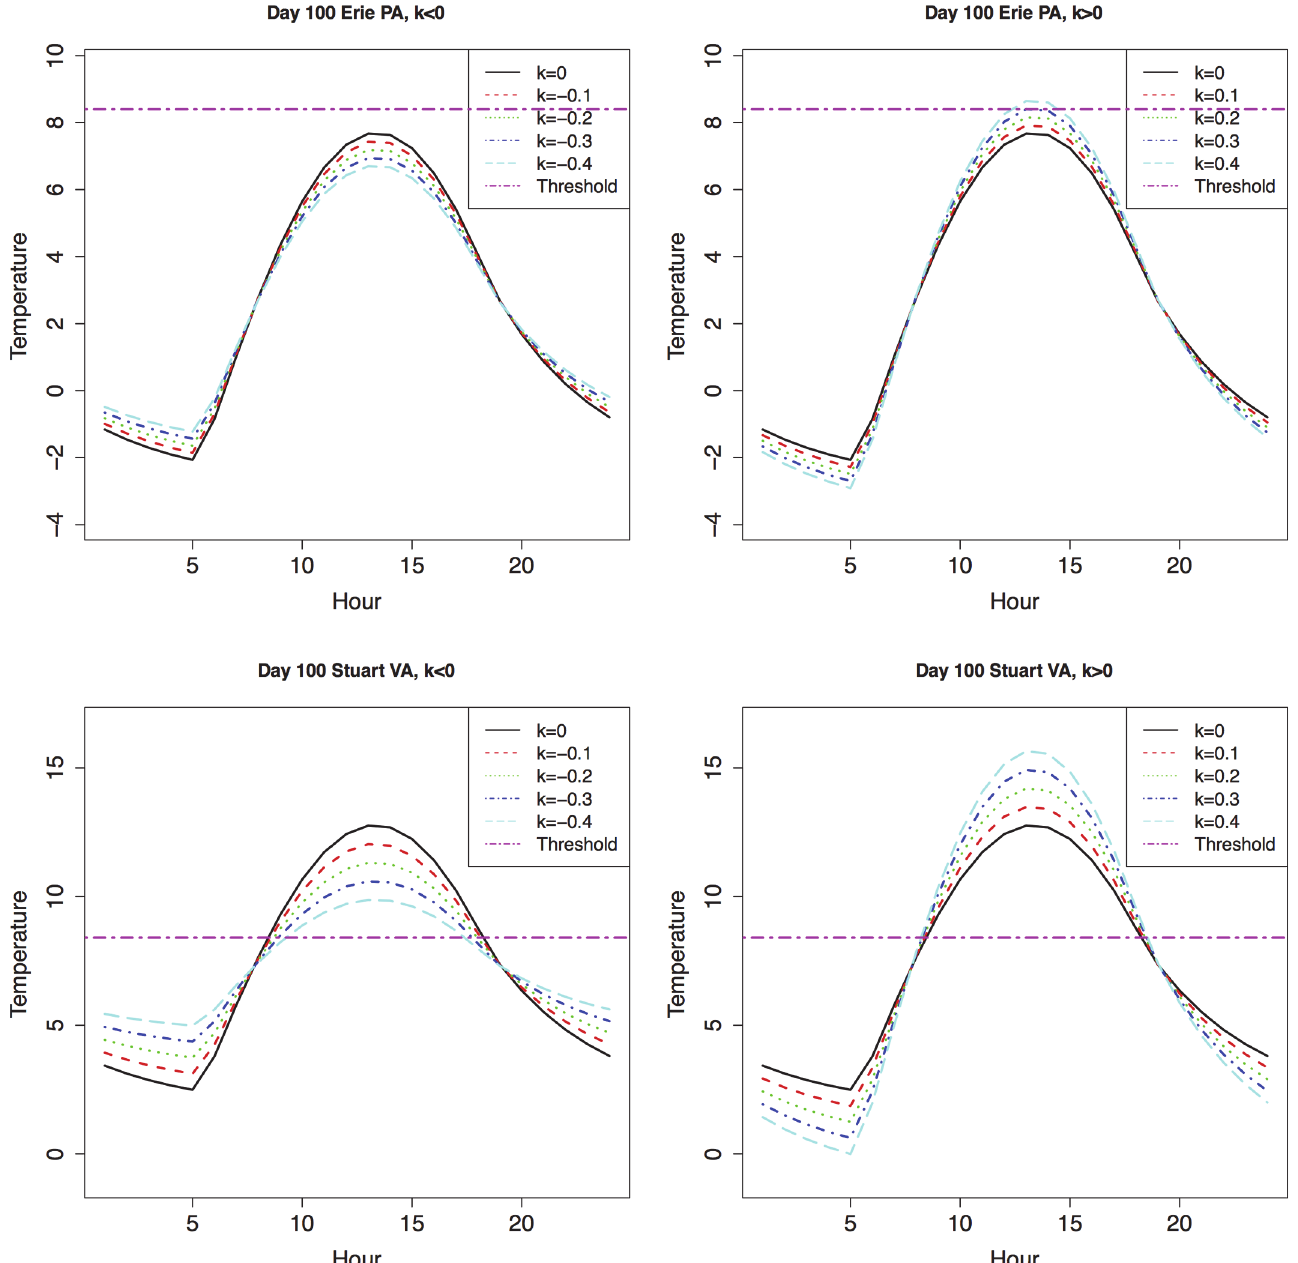
Fig 1. Degree-Days Accumulation at Erie PA and Stuarts Draft VA under the Same Mean with Various DTR Change Conditions. Note: Upper panels: Erie, PA; lower panels: Stuarts Draft, VA. Left panels: decreased DTR conditions ( k < 0); right panels: increased DTR conditions ( k > 0). With same mean temperature, the larger the DTR, the more degree-days can be accumulated in a